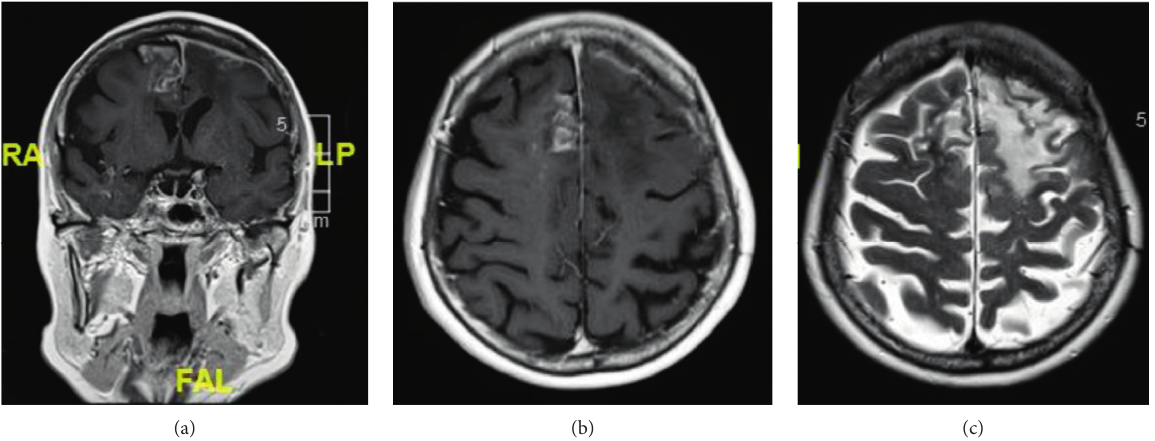
Figure 2: MRI brain. (a, b) Coronal and axial T1 postcontrast images showing pachymeningeal enhancement in the left frontal region and leptomeningeal enhancement in the left superior and middle frontal sulci, with vasogenic oedema. A nodular leptomeningeal enhancement is noted within the right parafalcine and superior frontal sulci with minimal underlying vasogenic oedema. There was no diffusion re- striction. (c) Axial FLAIR image showing the extent of the vasogenic